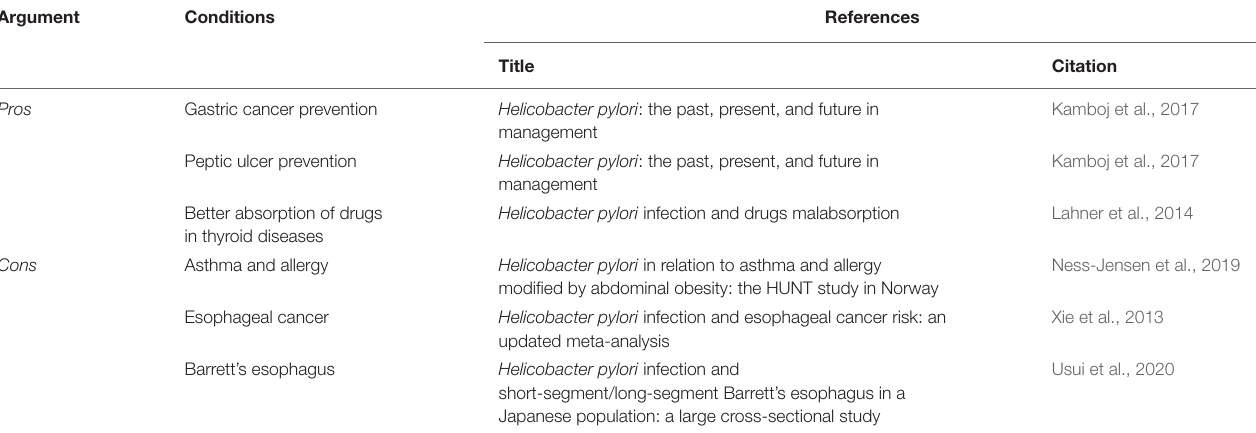
TABLE 1 | Relevant literature on the Pros and Cons of H. pylori infection. Argument